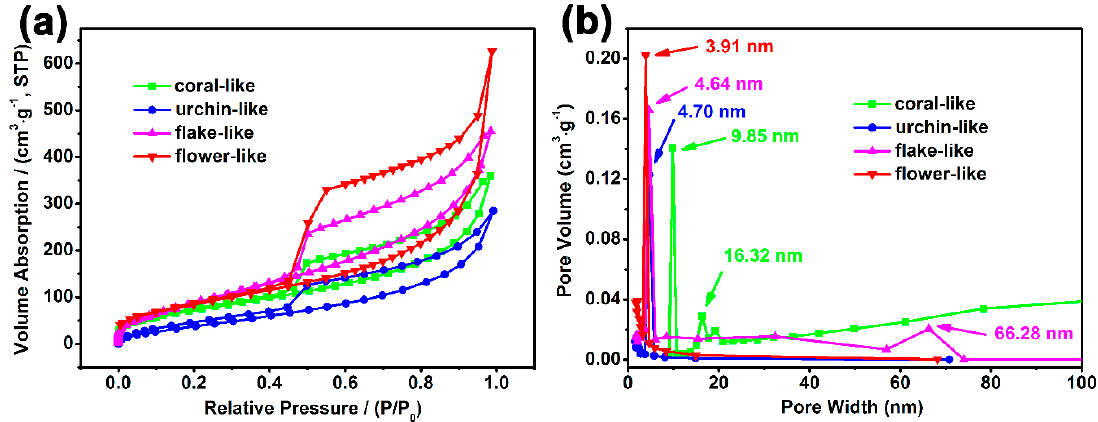
Figure 3. ( a ) Nitrogen adsorption–desorption isotherms and ( b ) the Barret–Joyner–Halenda (BJH) pore size distribution plots of the β -NiS with different morphologies at 77 K. Table 2. Pore size distributions of β -NiS with coral-like, urchin-like, flake-like, and flower-like morphologies.